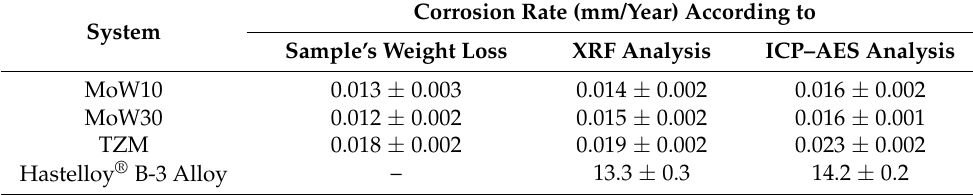
Table 4. Corrosion rates of molybdenum- and nickel-based alloys in liquid Bi–Li (5 mol.%) alloys determined by various methods after 100 h contact at 650 ◦ C.